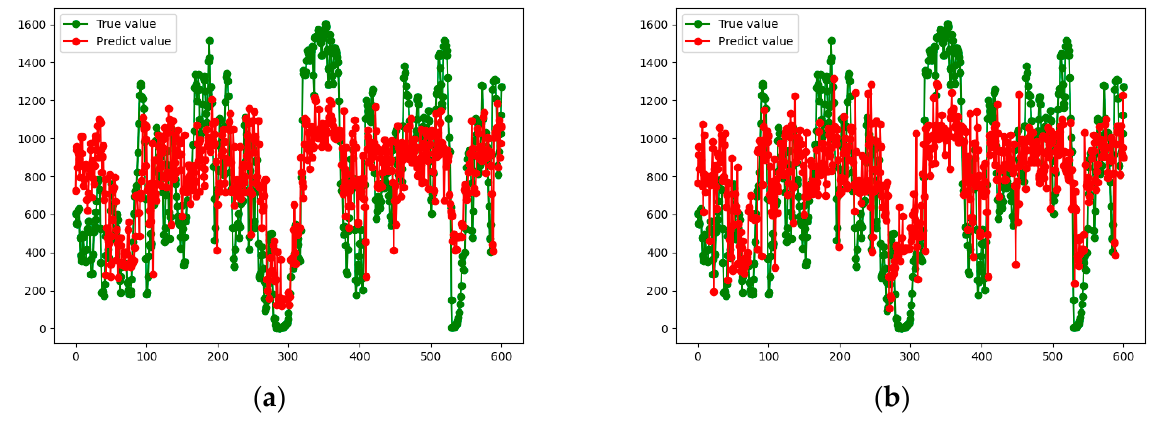
Figure 11. The prediction results by RF ( a ) and GBDT ( b ) for the vehicle of ***0710.